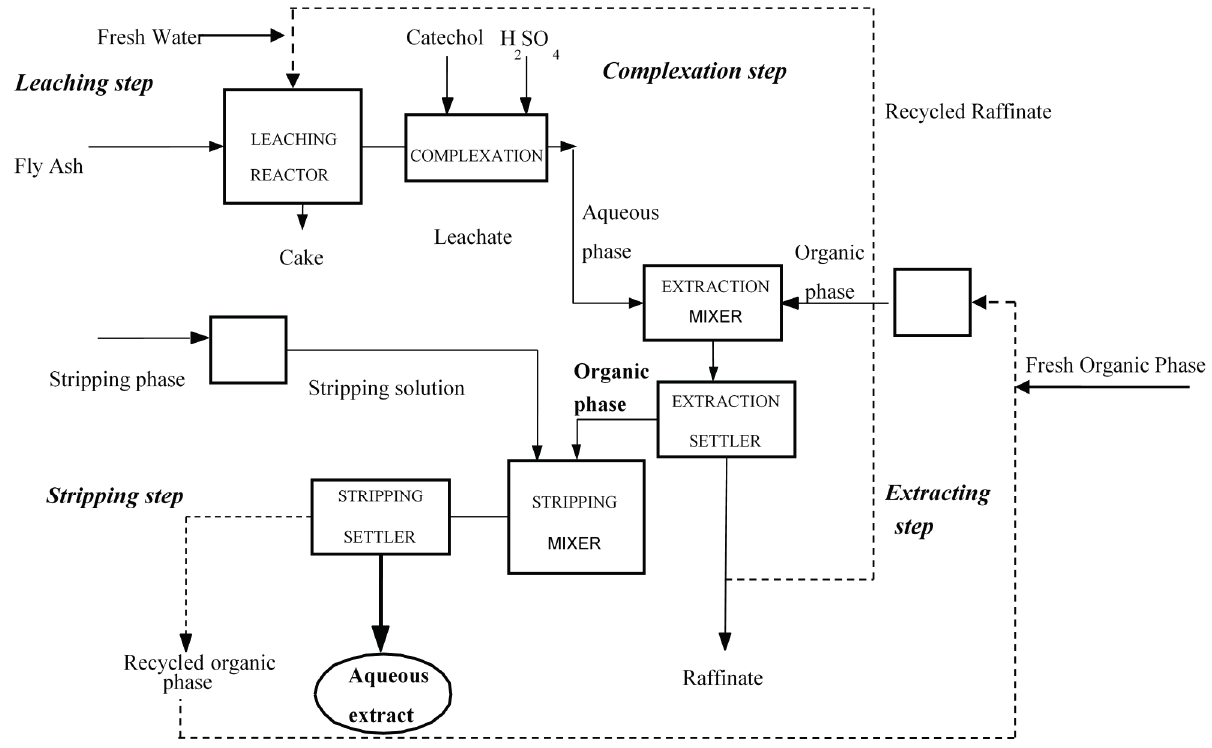
Figure 1. Pilot plant flow sheet